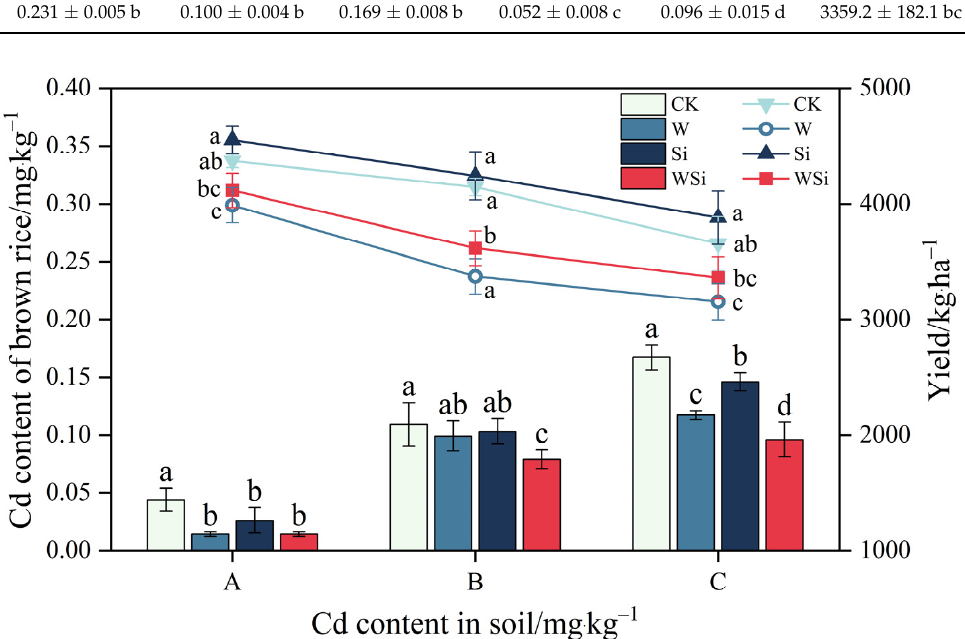
Figure 1. Synergistic effects of water management and silicon foliar spraying on Cd content of brown rice and rice yield. The histogram and line chart represent Cd content of brown rice and rice yield, respectively. The error bar represents three repeated standard deviations (SD). There is no significant difference between values with the same letters in the table ( p ≥ 0.05, Fisher’s LSD test). A, B and C represent the actual measured Cd content in soil after the addition of exogenous Cd at 0.20 mg · kg − 1 , 0.60 mg · kg − 1 and 1.60 mg · kg − 1 ,